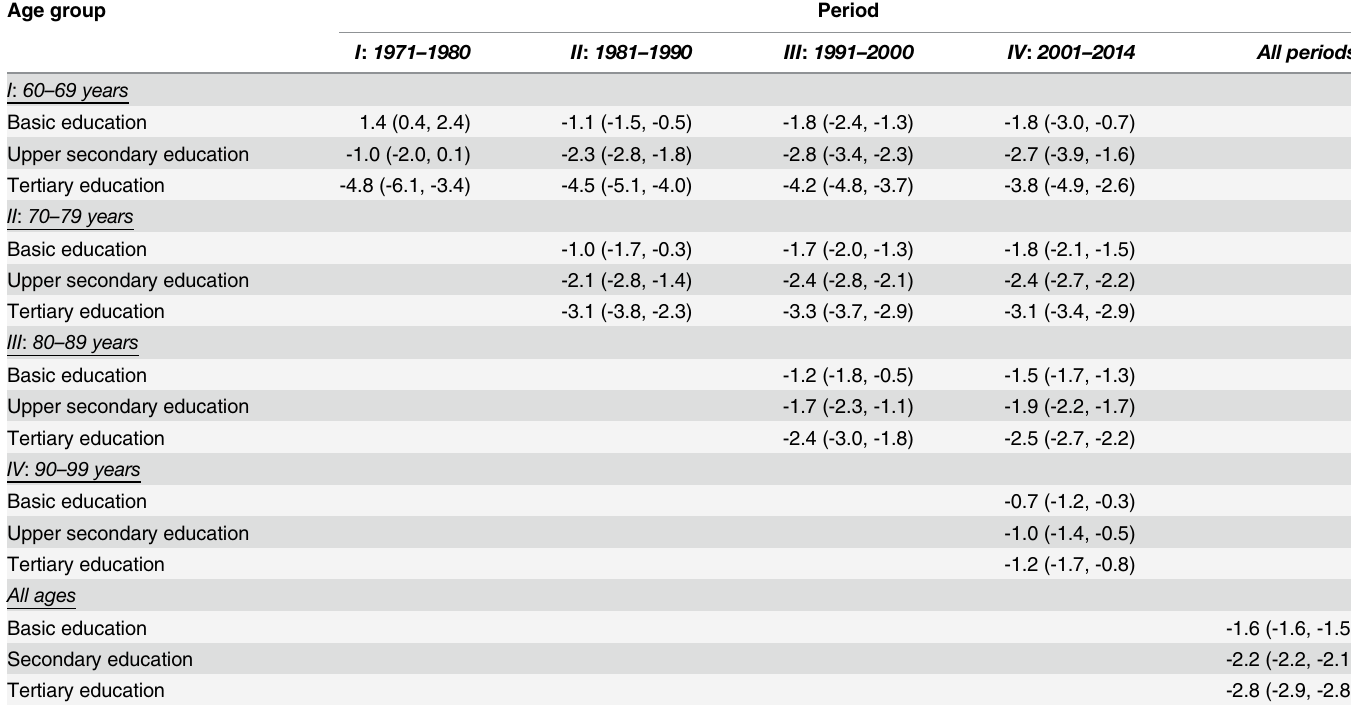
Table 2. Average annual change in one year death risk, in per cent (95% CI) from clog-log models by age group and period,